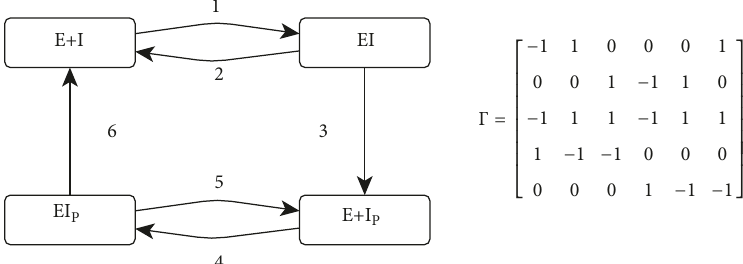
Figure 1: A discrete state chemical reaction network. Left: reaction network structure. The nodes and directed edges represent the complexes and the reactions, respectively. The numbers on the edges denote a fixed ordering of the reactions. Right: the stoichiometric matrix associated with the system, i.e. [Γ] 𝑖𝑗 is the net change in the number of the 𝑖 ’th species upon occurring the 𝑗 ’th reaction.